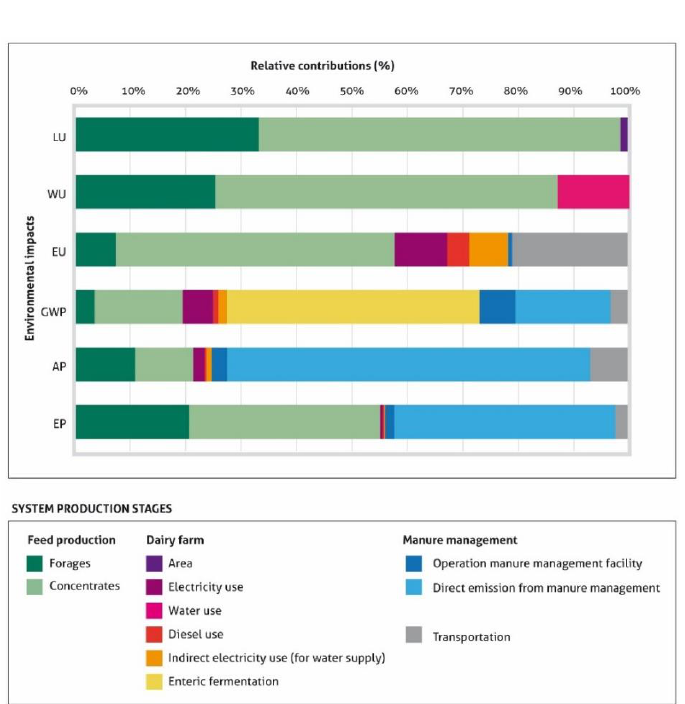
Figure 2. The share (%) of various stages in the milk production LCA.